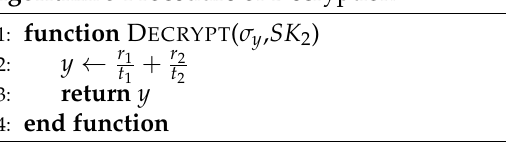
Algorithm 5 Procedure of